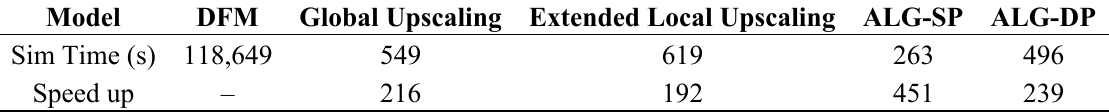
Table 4. Simulation time and speed up for case 2.